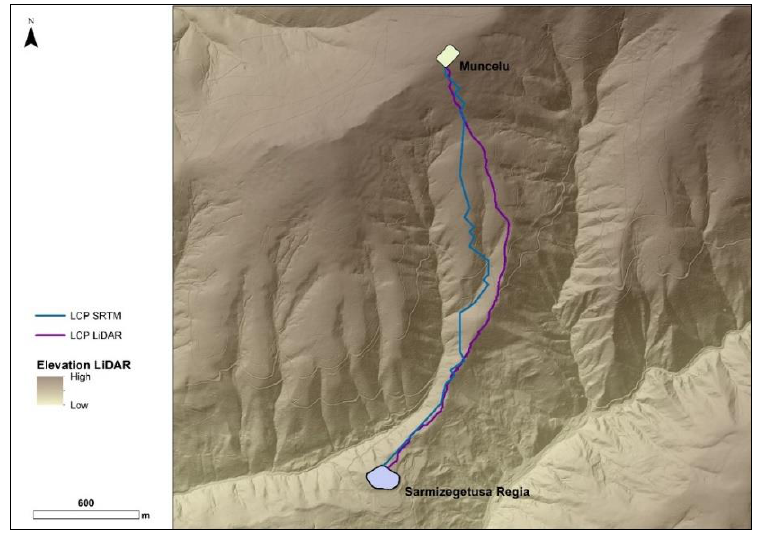
Figure 3. Least-Cost Paths (LCP) from Sarmizegetusa Regia to Muncelu calculated from LiDAR and SRTM DTMs.